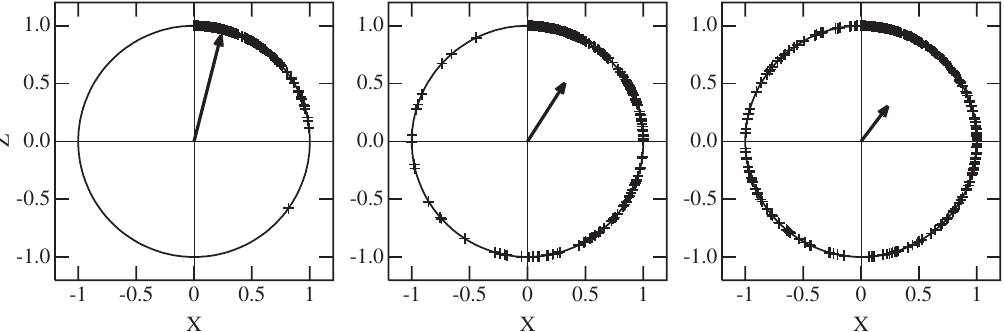
FIG. 11. A sample distribution of the points along a unit circle in the horizontal plane (X sideways and Z along the beam direction) that indicates the spin directions of an ensemble of particles for three values of the time index, n ¼ 0 . 25 , 1, and 4 going from the left panel to the right. The starting point at n ¼ 0 is at the top of the graph. Since the changes in spin tune go as the square of the angles, all deviations from the reference orbit are positive and the distribution spreads in only one direction around the unit circle, shown here as clockwise. The tail of the distribution is evident as the population of spin directions becomes thinner along the circumference of the unit circle. Only one Gaussian distribution of points was used, which is equivalent to α ¼ 0 . The arrows show the direction and magnitude of the resulting polarization. The three values of the magnitude are 0.95, 0.60, and 0.38. These values form a part of the template for α ¼ 0